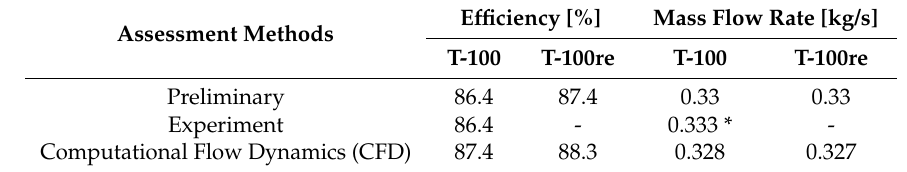
Table 6. Comparison of total-to-static efficiency and mass flow rate under the design condition.